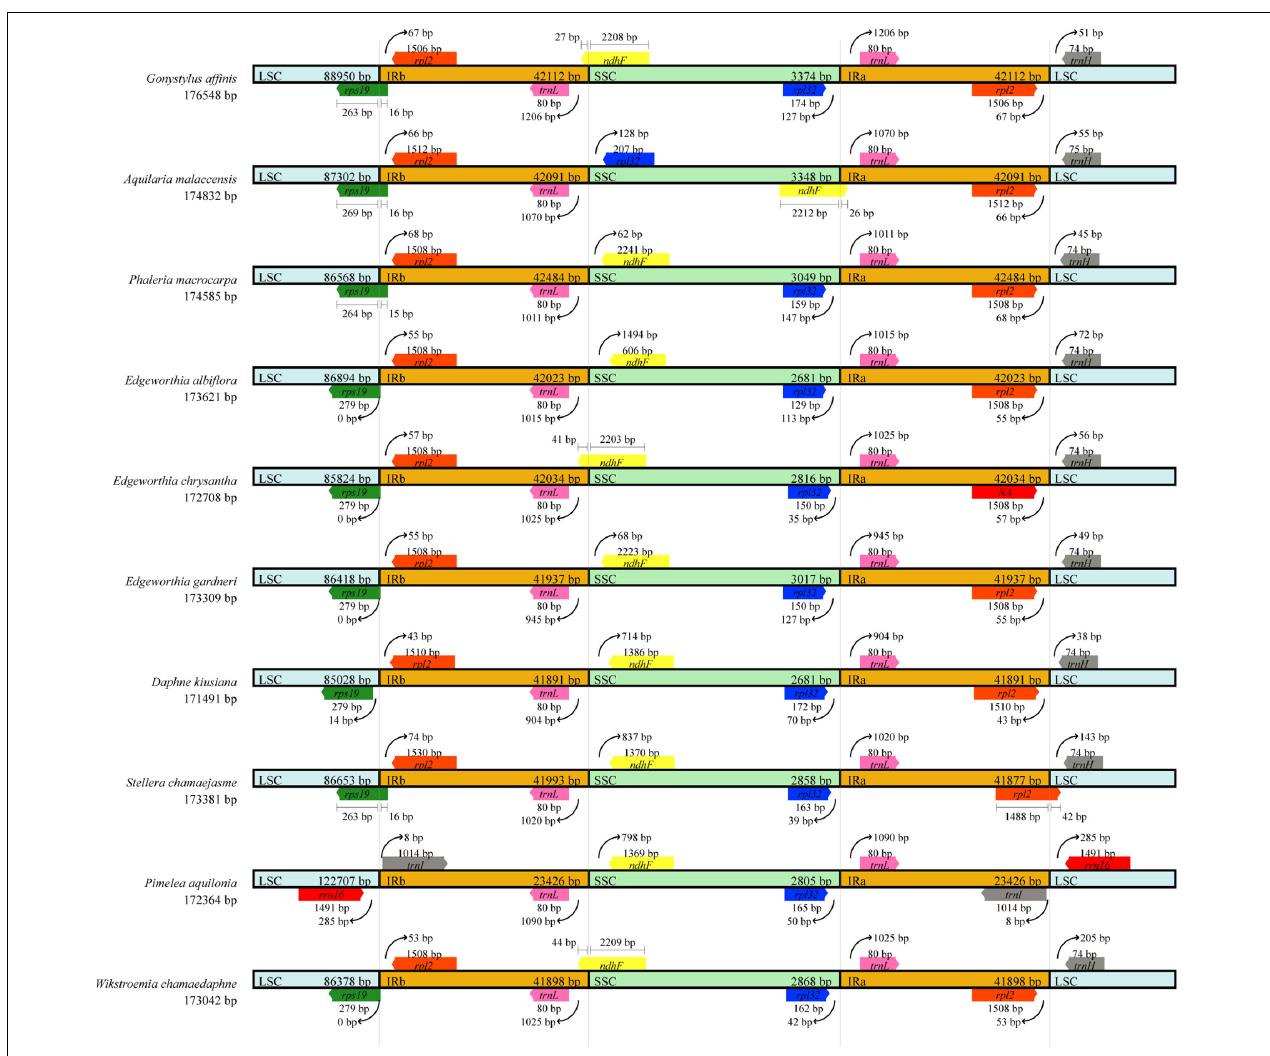
FIGURE 3 | Comparison of borders between large single-copy (LSC), small single-copy (SSC), and inverted repeat (IR) regions across ten chloroplast genomes of Thymelaeaceae.